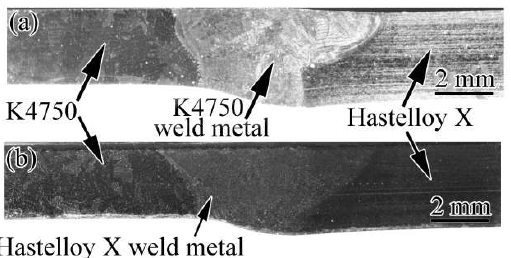
Figure 5. Macrostructure of dissimilar joints with different filler materials: ( a ) K4750 filler material; and ( b ) Hastelloy X filler material.